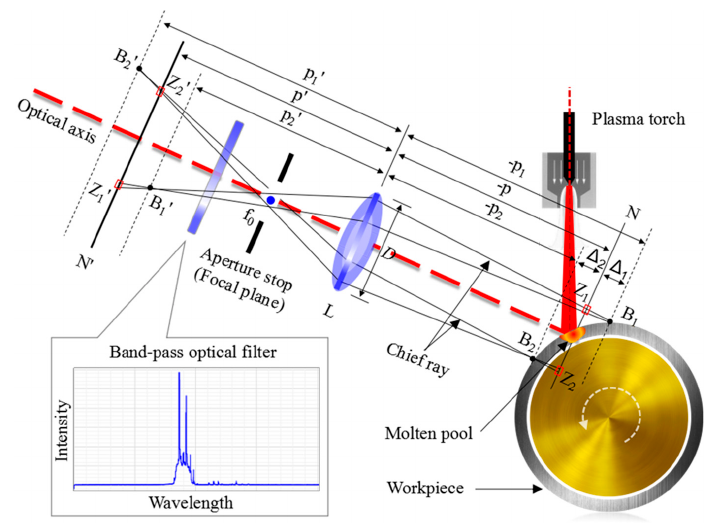
Figure 2. Image formation for dynamic mesoscale weld pool in MPAW using an object-side telecentric optical model.